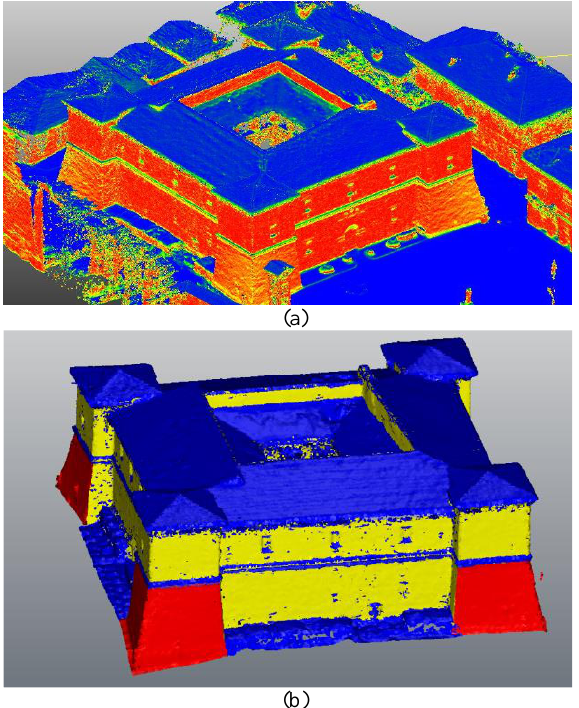
Figure 3. Architectural scale cloud segmentation. (a) Geomatric Feature, Verticality analysis . (b) the segmented point